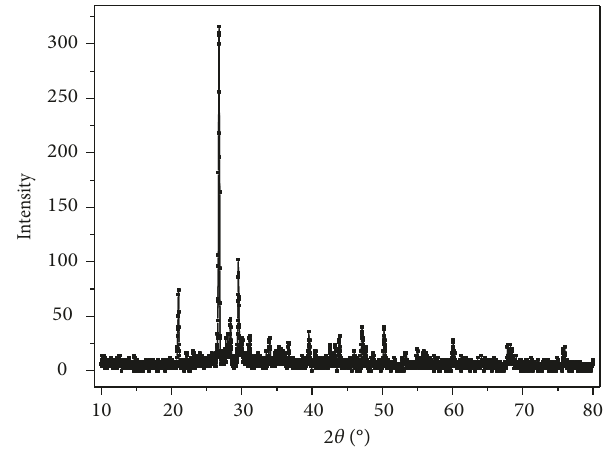
Figure 2: XRD pattern of CPB sample.